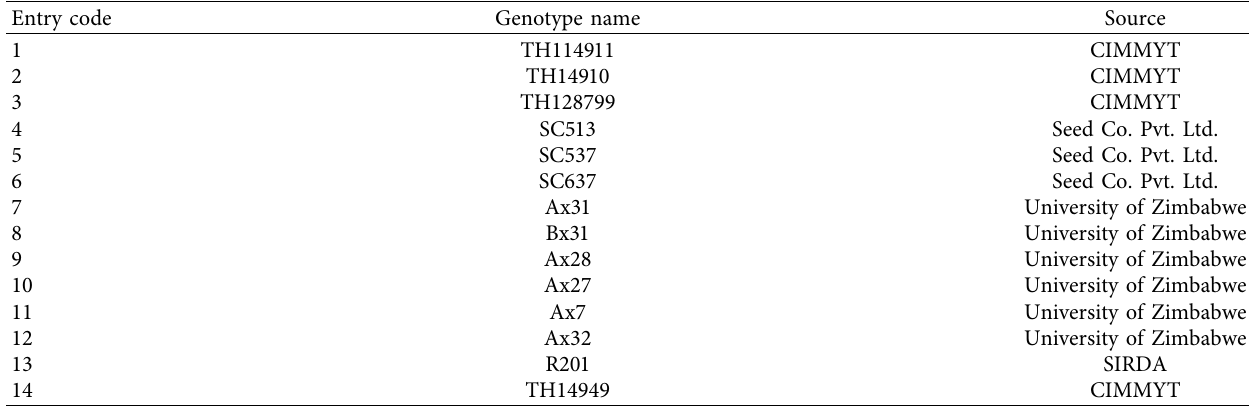
Table 1: Maize germplasm used in the experiments.